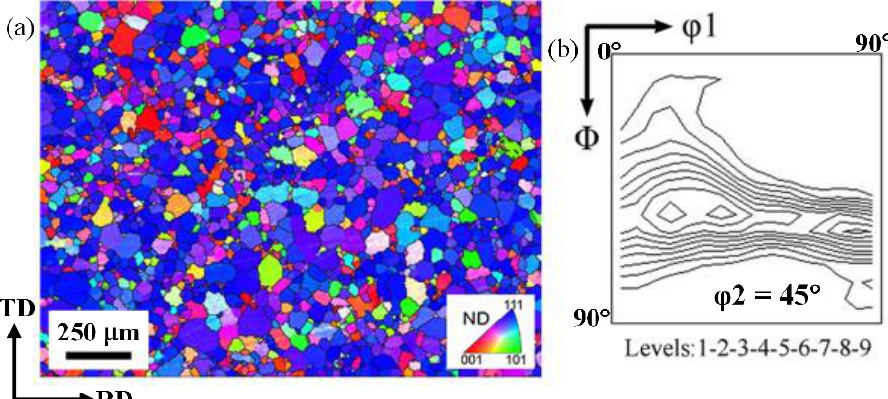
Figure 5. EBSD map of commercial 800-grade electrical steel measured on rolling plane. ( a ) orientation map; ( b ) orientation distribution function (ODF) figure at ϕ 2 = 45° section. map; ( b ) orientation distribution function (ODF) figure at φ